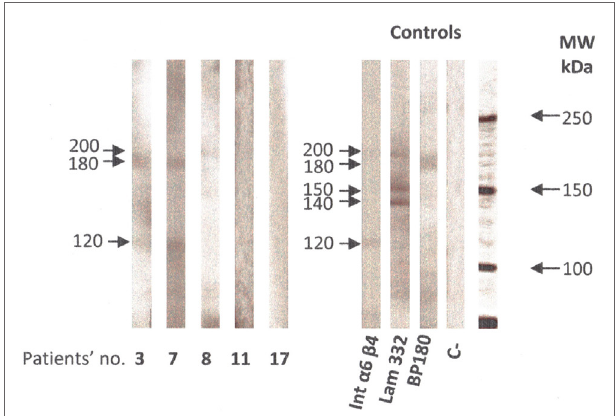
FigUre 5 | Immunoblot on amniotic membrane extract with sera from patients 3, 7, 8, 11, and 17 of the suggestive-or-compatible gliptin-induced mucous membrane pemphigoid group, was performed as previously described (30). Positive controls were α 6 β 4 integrin, laminin 332, and BP 180 antigen; C − was a negative control with normal human serum. Abbreviation: MW, molecular